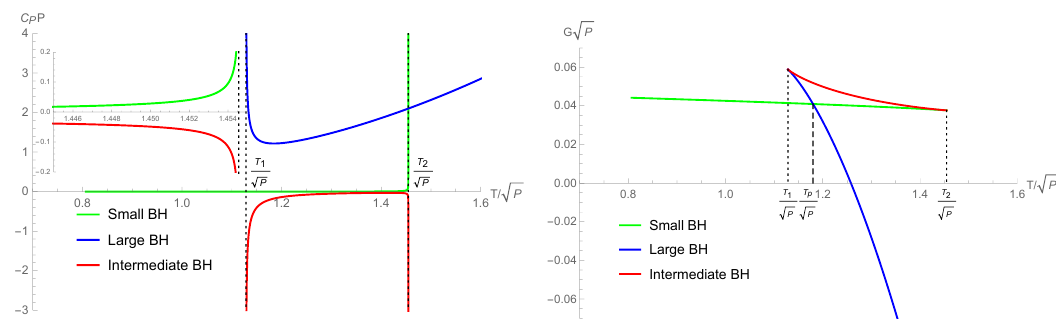
p p Figure 6 . Plots of C p P and G P against T= P for a RN black hole in a cavity with Q = p 0 : 05 = P < Q c . Left Panel : positive C p means that Large BH and Small BH are thermally stable while negative C p gives Intermediate BH is thermally unstable. Right Panel : as T= p from T min = P , a (cid:12)rst-order phase transition from Small BH to Large BH occurs at T = T p .